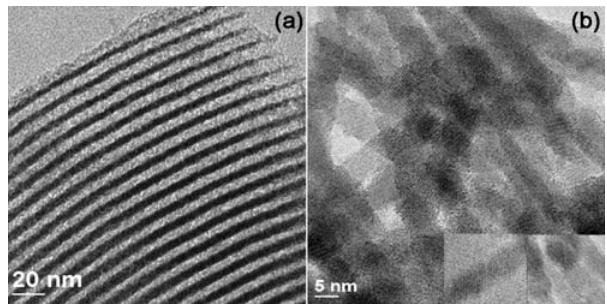
Figure 1. TEM images of nanowires: (a) V permission of Wiley-VCH); (b) WO the permission of